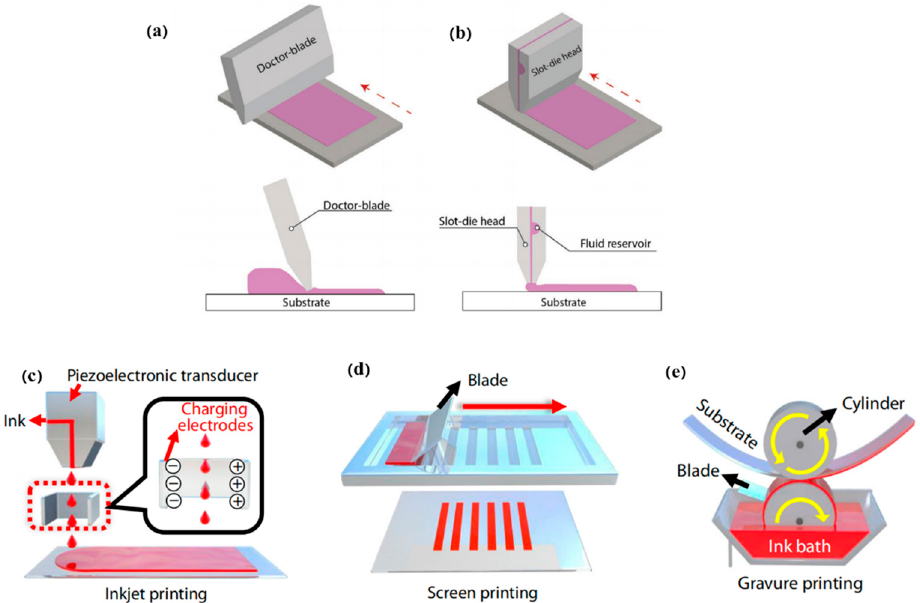
Figure 5. Schematic representations of: ( a ) Blade coating and ( b ) Slot-die coating. Adapted with permission from Ref. [23]. Copyright 2022 Wiley − VCH ( c ) Inkjet printing, ( d ) Screen printing, and ( e ) Gravure printing. Adapted with permission from Ref. [16]. Copyright 2022 Chinese Chemical Society.